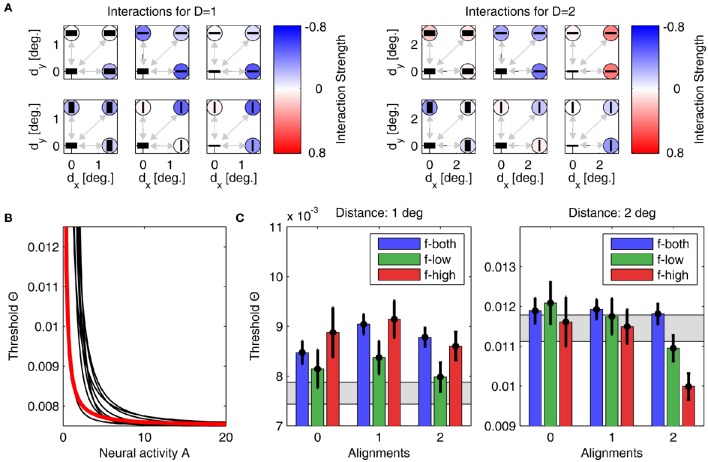
Parameters and performance of model A. For this figure, we used the parameter set yielding model results best matching the experimental data. (A) Interactions for plaid distances d = 1° (left) and d = 2° (right). The six subplots corresponding to each plaid distance show interactions between the neuronal unit in the lower left corner to all other units, with their orientation preferences and SFs indicated by the black bars (thick bar for low SF, thin bar for high SF). Interaction strength is color coded (insides of circles). The upper row displays all interactions for units with similar orientation preferences, while the lower row displays interactions between units with orthogonal orientation preferences. The outer columns display interactions between units with similar SFs, while the middle column displays interactions between units with different SFs. For simplifying the figure, the original plaid configuration has been rotated by 45 degrees. (B) Mapping of activities onto thresholds for the 'best' model (thick red line), and for nine other models with the next-best performances (thin black lines). (C) Comparison of detection thresholds from model and experiment for plaid distances d = 1° (left) and d = 2° (right). The predicted thresholds from the model are displayed as colored bars (color code as inset), while the psychophysical thresholds are indicated by the black circles with the vertical lines showing the corresponding 95%-confidence intervals. The region shaded in gray color indicates the range of thresholds expected from probability summation. Note that model predictions and actual thresholds are indistinguishable from each other.